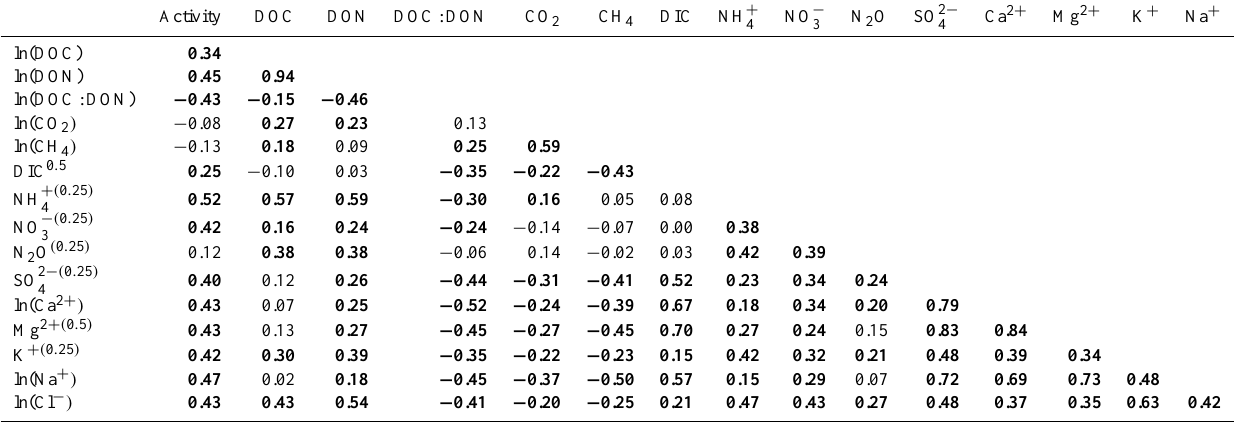
Table 2. Correlations between water chemistry parameters for 83 thermokarst features and 61 reference water tracks and first order streams.